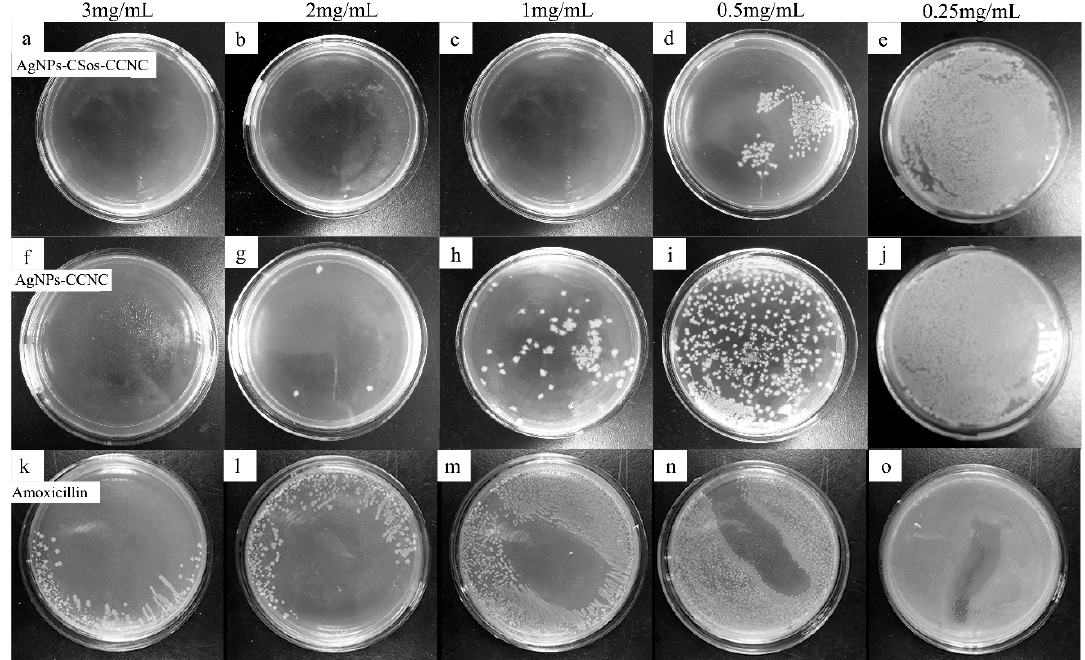
Figure 6. Antimicrobial activity of AgNPs-CSos-CCNC, AgNPs-CCNC and amoxicillin evaluated with E. coli . The antimicrobial agent concentrations were shown on the top of each plate. ( a – e ) the colony growth with AgNPs-CSos-CCNC, ( f – j ) the colony growth with AgNPs-CCNC, ( k – o ) the colony growth with amoxicillin.